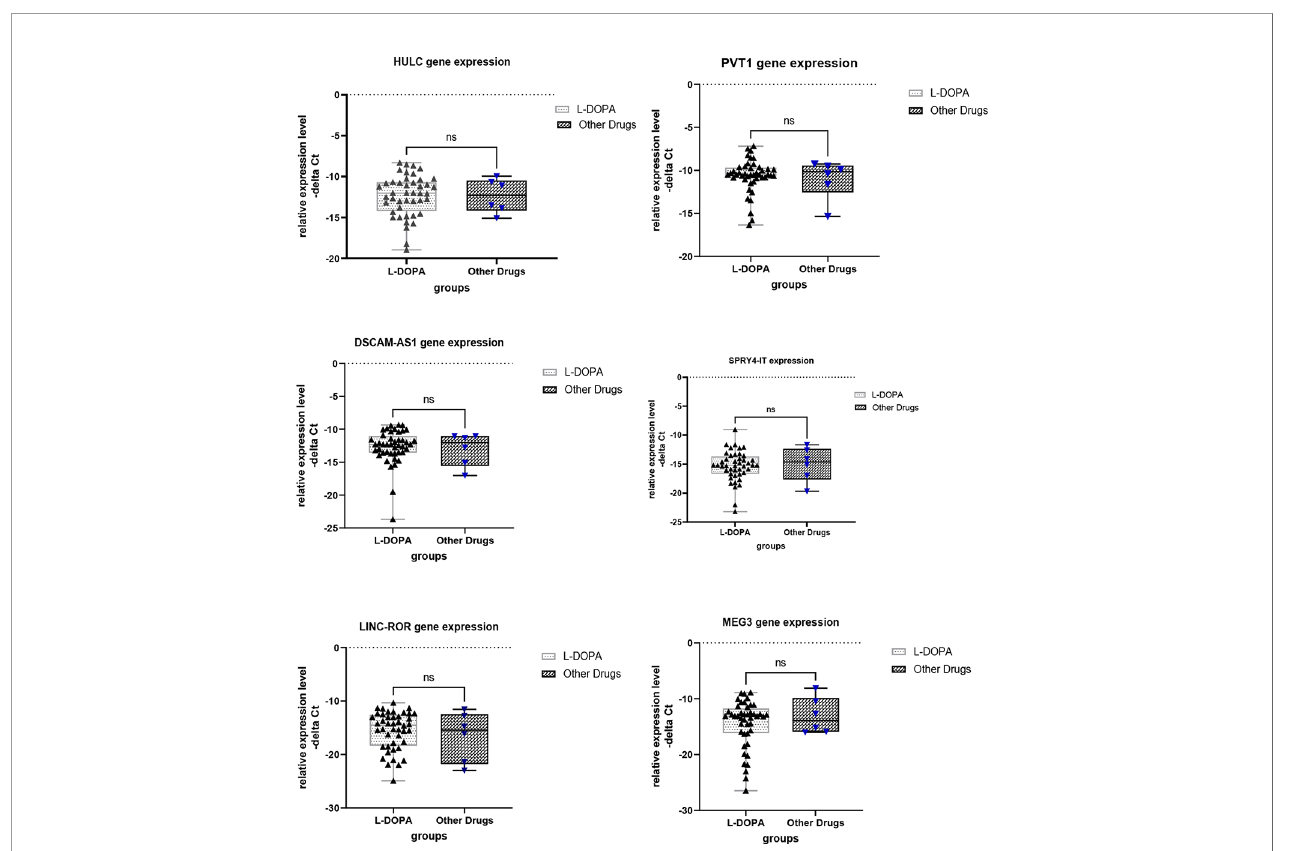
FIGURE 4 | Comparison of expression levels of lncRNAs between patients receiving L-DOPA and those under treatment with other drugs. ns, not signi fi